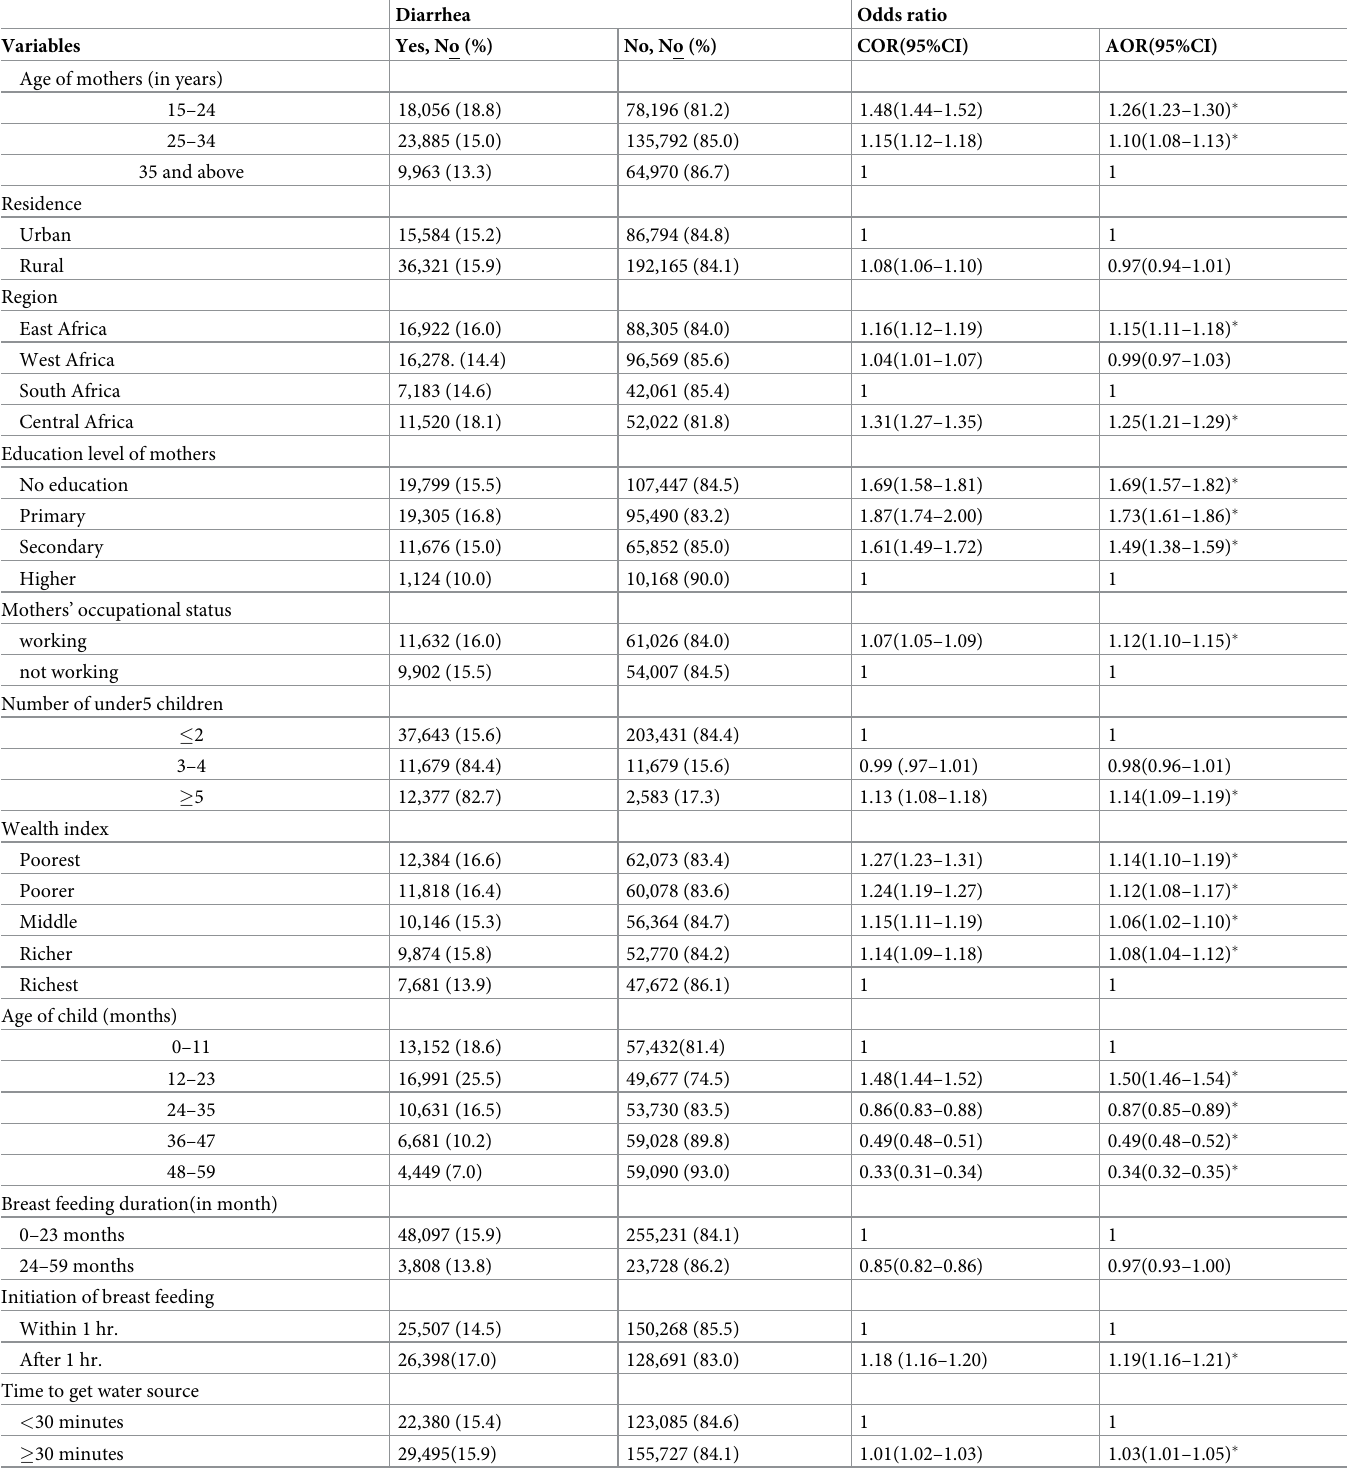
Table 5. Multilevel regression analysis of diarrhea among under-five children in sub-Saharan